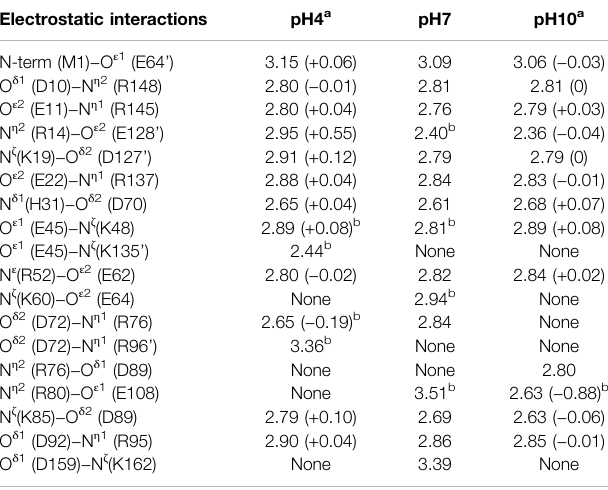
TABLE 2 | Comparison of the electrostatic interactions observed in the structures at different pH. Selected interactions within 3.6 Å are listed (Cohen et al., 2008), where their coordinate uncertainties were estimated from the Cruickshank ’ s DPI (diffraction-component precision index) to be 0.04 Å for the structure at pH4, 0.03 Å for that at pH7, and 0.03 Å for that at pH10, respectively (Vaguine et al.,